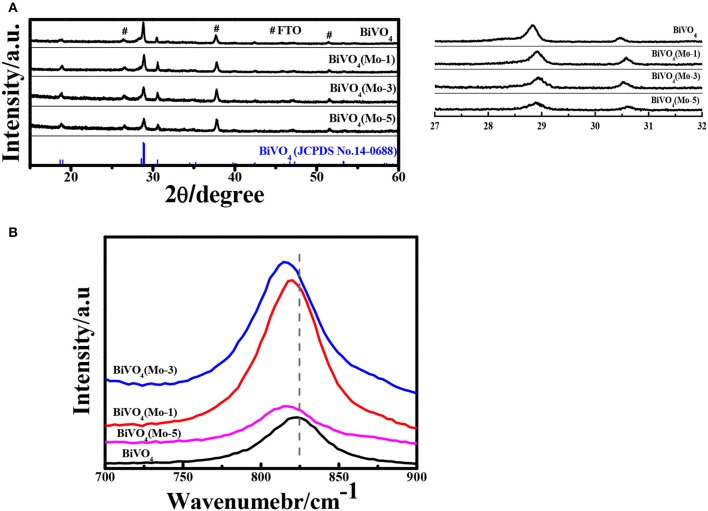
(A) XRD patterns; (#: FTO) (B) Raman spectra of pure BiVO4 and Mo doped BiVO4 with different concentration.